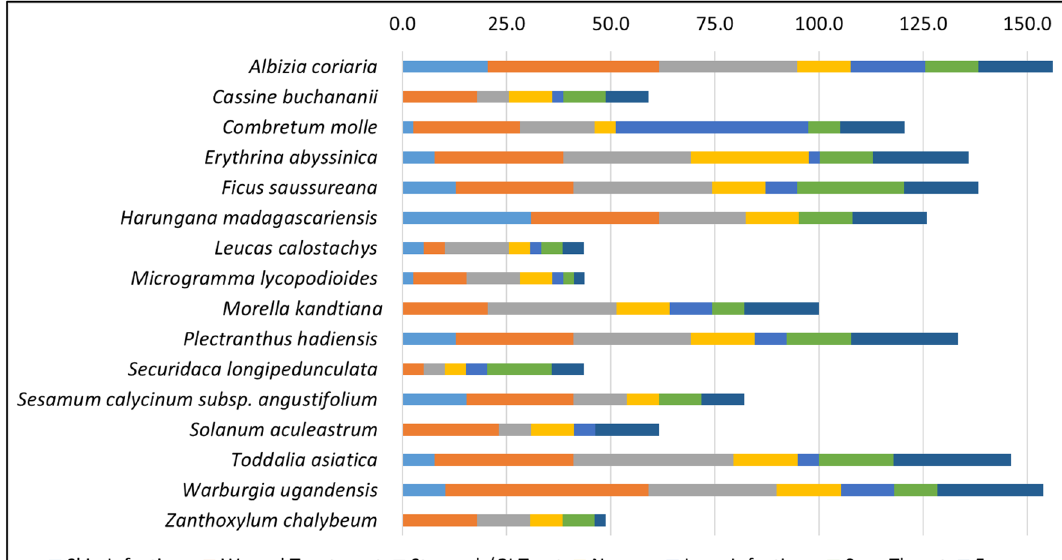
Figure 1. Ethnopharmacological information on the medicinal use of plant candidates from the Greater Mpigi region in Uganda (with emphasis on infections and symptoms of infections). The stacked histogram figure shows the relative frequencies of citation (RFC) in % in treatment of relevant medical disorders, calculated from data obtained through an ethnobotanical survey of 39 traditional healers. Here, the RFC assesses the importance of a plant species used for a specific medical condition relative to the total number of informants interviewed in the study. It varies from 0% (none of the informants uses this plant species in treatment of a specific medical condition) to 100% (maximum number of informants use this plant species in treatment of a specific medical condition) 24 . Consequently, the higher the value of cumulated RFCs (x-axis), the higher the traditional use of a plant species in treatment of medical conditions relevant to this